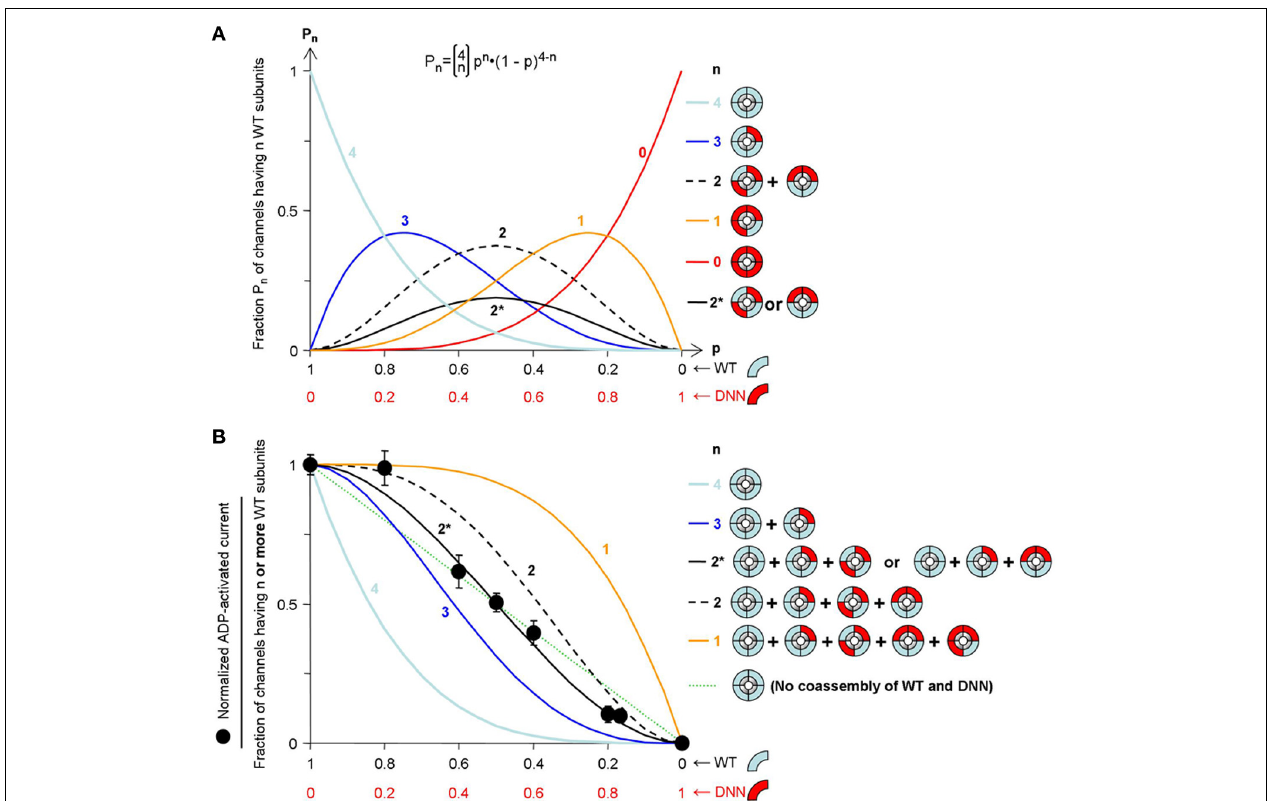
Probability of a channel having n or more WT subunits calculated using the distributions of (A) (n indicated above the curves). The straight dotted line represents the probability of a WT channel if WT and mutant could not co-assemble. The symbols represent normalized ADP-activated current, calculated by normalization of the experimental data of Figure 3I . The rmsd of the experimental data from each model is: 0.327 ( n = 4), 0.124 ( n = 3), 0.119 ( n = 2), 0.352 ( n = 1), 0.031 ( n = 2 ∗ ), and 0.071 (no WT/mutant mixing; dotted straight